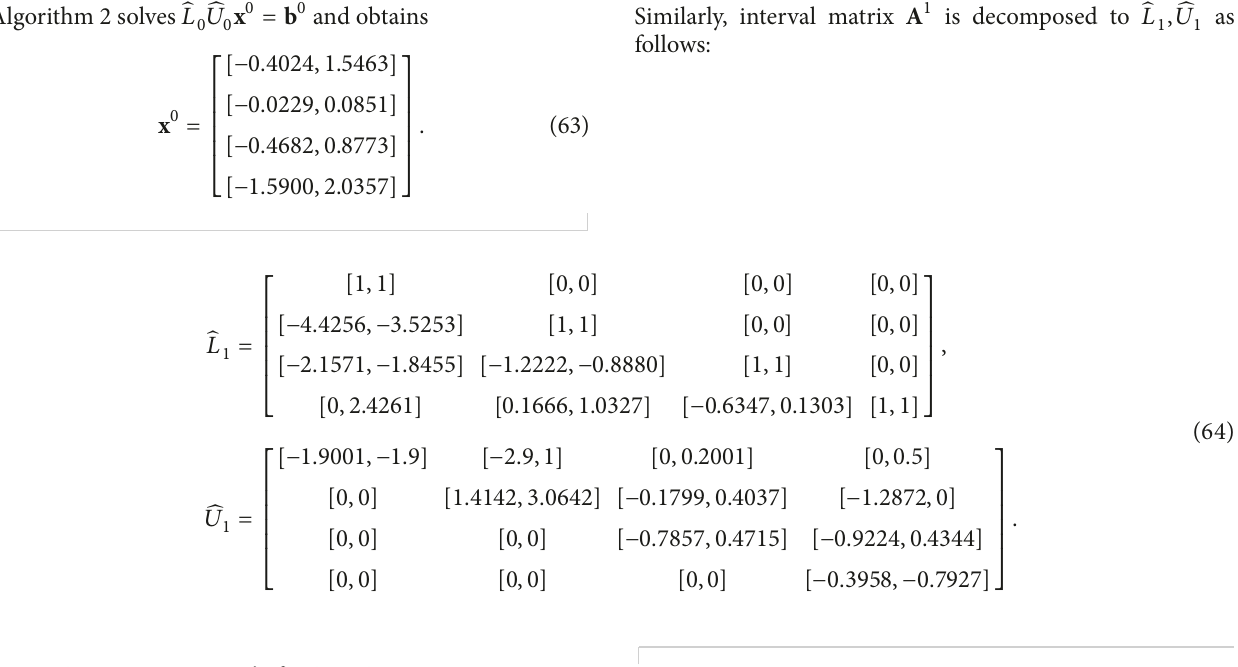
̂𝑈 ̂𝐿 x 0 = b 0 and 0 0